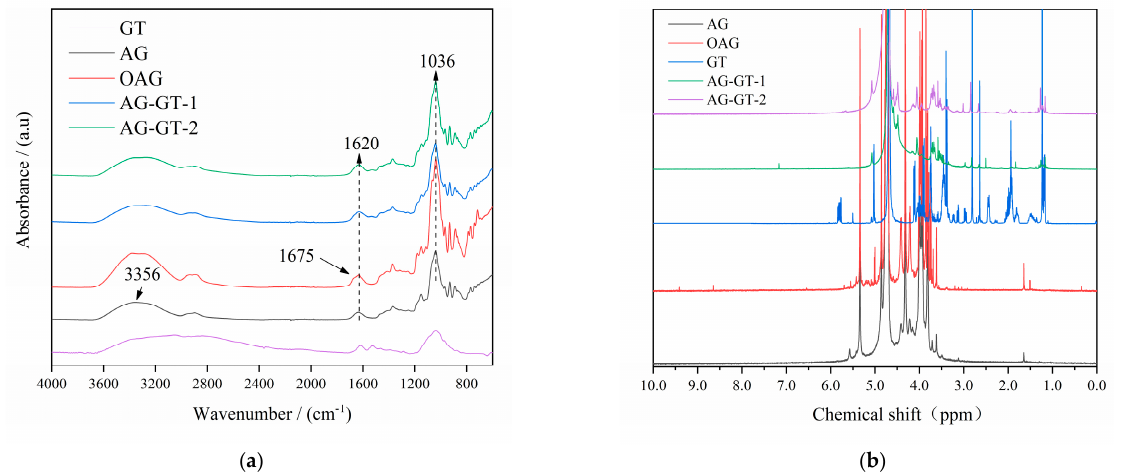
Figure 1. FTIR spectra ( a ) and 1 H NMR spectra ( b ) for GT, AG, OAG, AG-GT-1 and AG-GT-2. Table 1. Elementary mass percentage for AG, OAG, AG-GT-1 and AG-GT-2. Samples